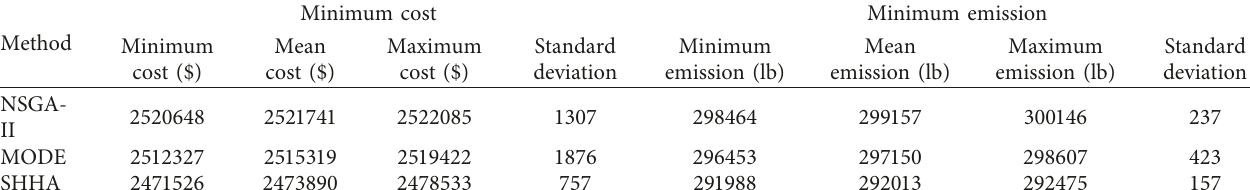
Table 9: Comparison with MODE and NSGA-II for Case